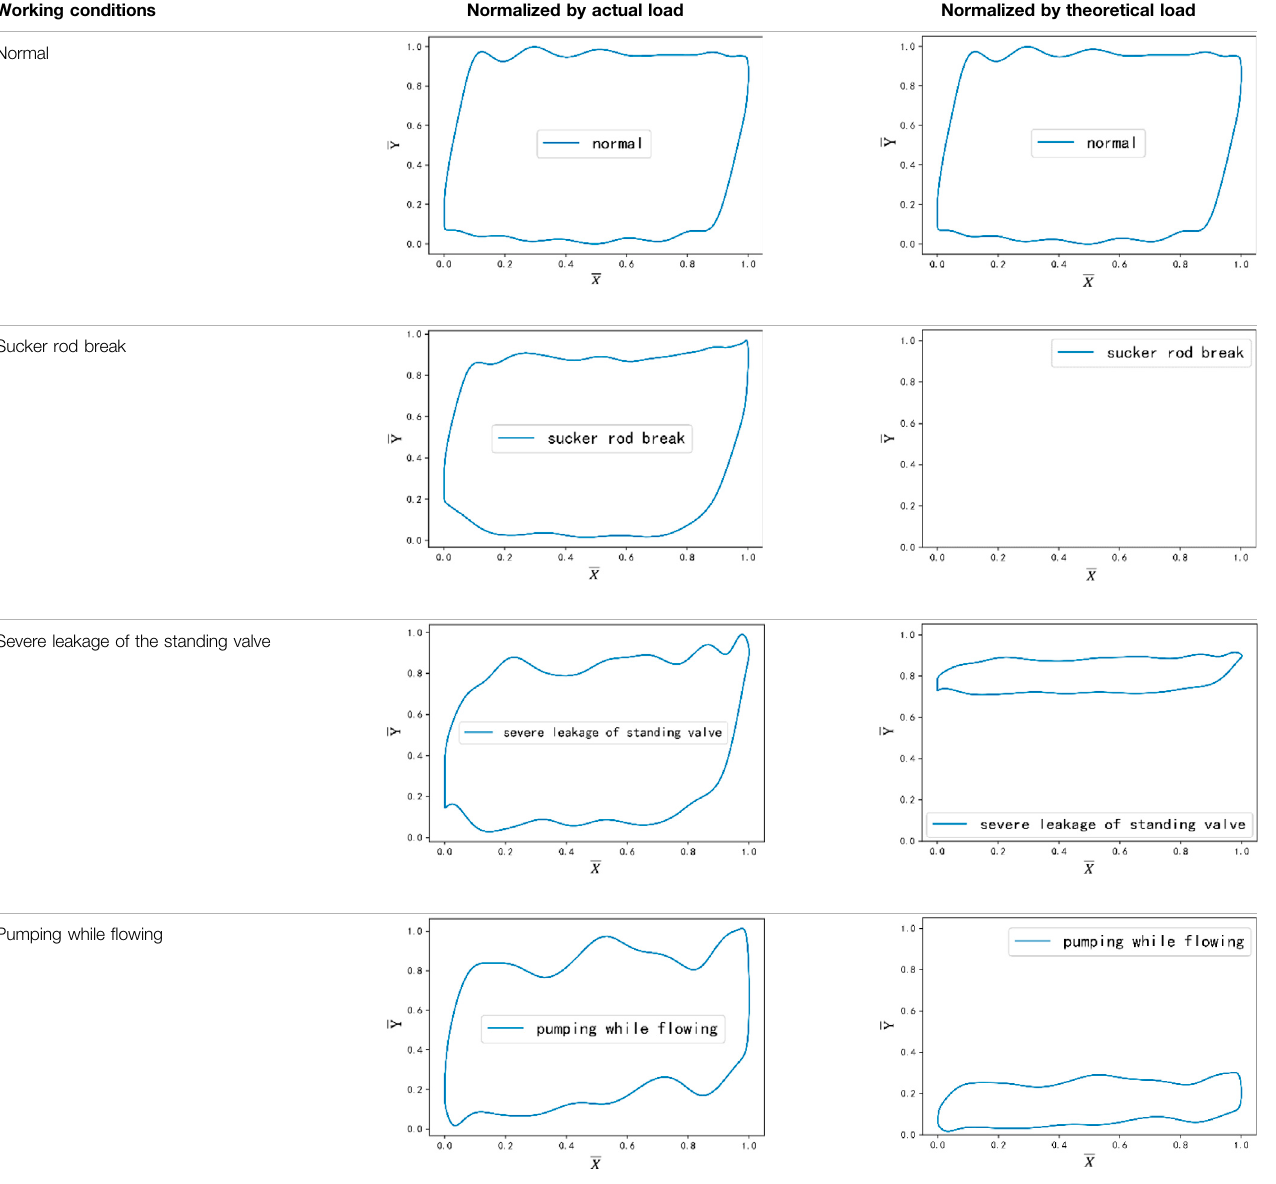
TABLE 2 | Normalized dynamometer card combining two normalization methods. Working